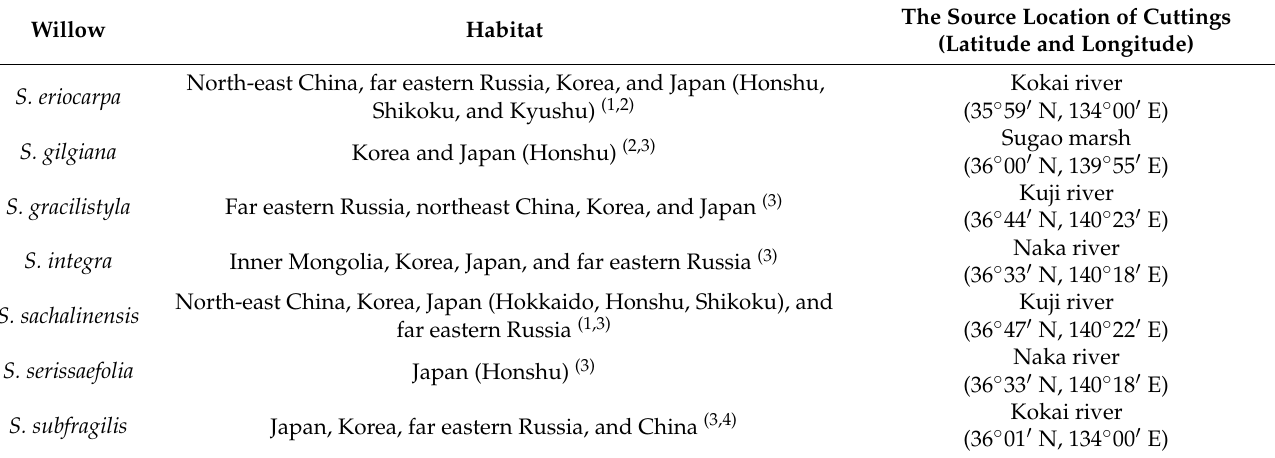
Table 1. Habitat, range of distribution, and the geographical sources of the seven willow species used to generate cuttings for planting in the